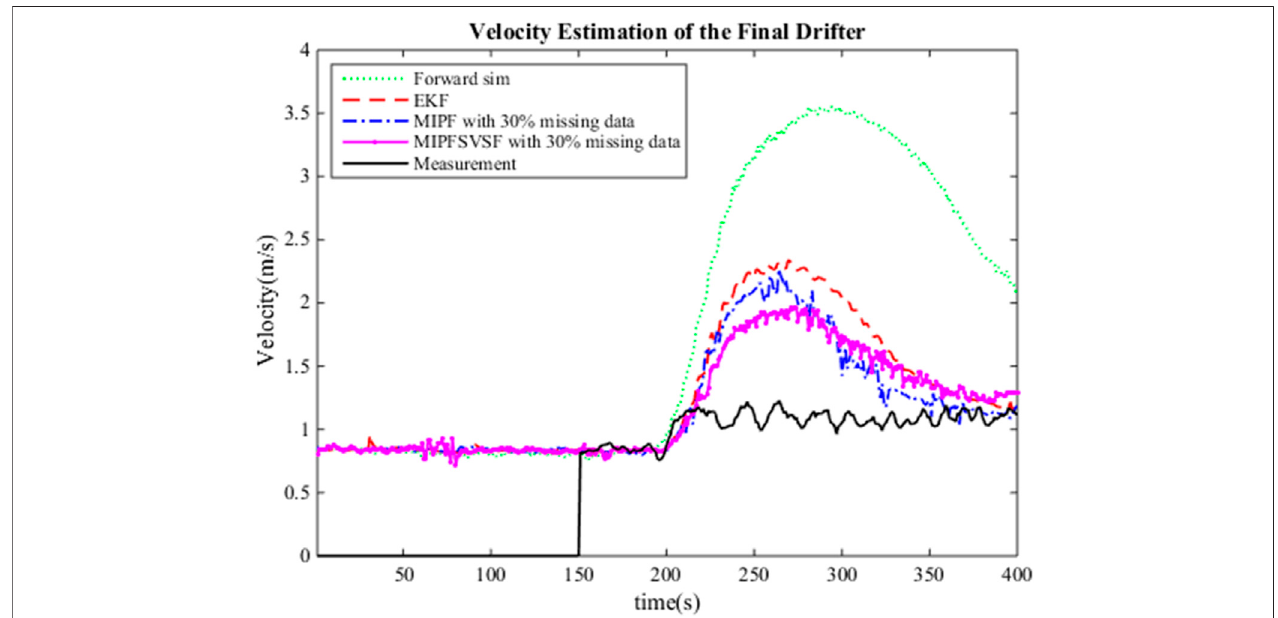
FIGURE 2 | Estimated velocity of the fi nal drifter using forward simulation, EKF during no missing data, MIPF with 30% missing data, and MIPF-SVSF with 30% missing data.